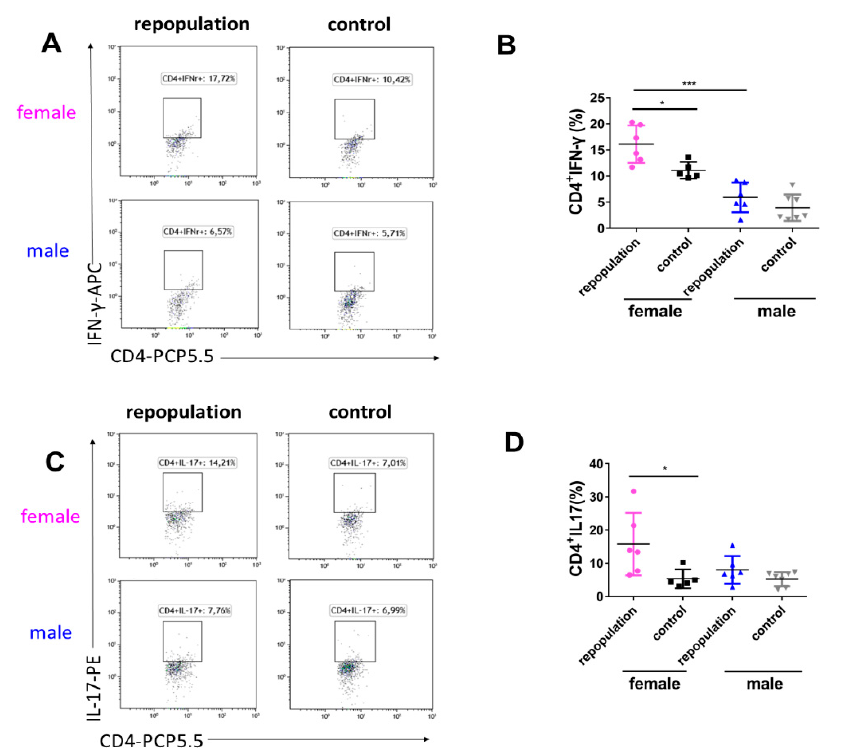
Figure 6. Elevated cytokine production during EAE peak in female microglia-repopulated mice. ( A , B ) Flow cytometry data showing the expression of IFN- γ in CD4 + T cells from the brains of Cx3cr1 CreER /+ Rosa26 DTA /+ and Cx3cr1 CreER /+ mice. ( C , D ) Flow cytometry data showing the expression of IL-17 in CD4 + T cells from the brains of Cx3cr1 CreER /+ Rosa26 DTA /+ and Cx3cr1 CreER /+ mice. (B,D) Representative numbers indicate the percentage of each compartment. n = 6, 5, 6 and 7 mice in female repopulation, female control, male repopulation and male control groups, respectively. Statistical significance is indicated as * p < 0.05 and *** p <